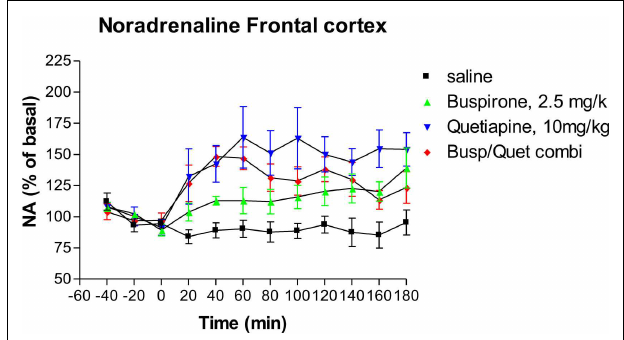
FIGURE 2 |The effect of Buspirone (2.5mg/kg i.p.) alone ( n = 7), Quetiapine (10mg/kg i.p.) alone ( n = 7), the combination of these two drugs (Busp/Quetcombi; n = 7), and saline vehicle control (saline; n = 9) on extracellular levels of noradrenaline in rat frontal cortex. Drugs were administered at time zero, values are means ± sem. Both the buspirone alone and quetiapine alone groups were statistically different from saline controls. However, there were no statistically significantly differences between the combination of buspirone and quetiapine from either drug when given alone.